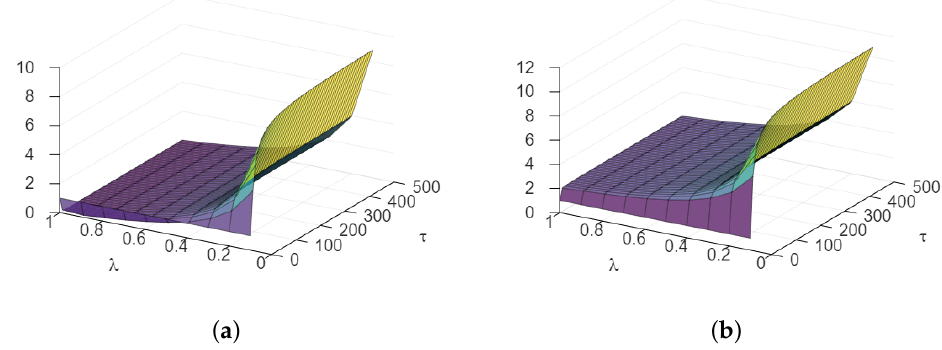
Figure 1. Plots of ( a ) z = | 1 − τ ( 1 + τλ ) − 1 | and ( b ) z = | 1 + τ ( 1 + τλ ) − 1 | for 0 < λ ≤ 1 and 0 < τ ≤